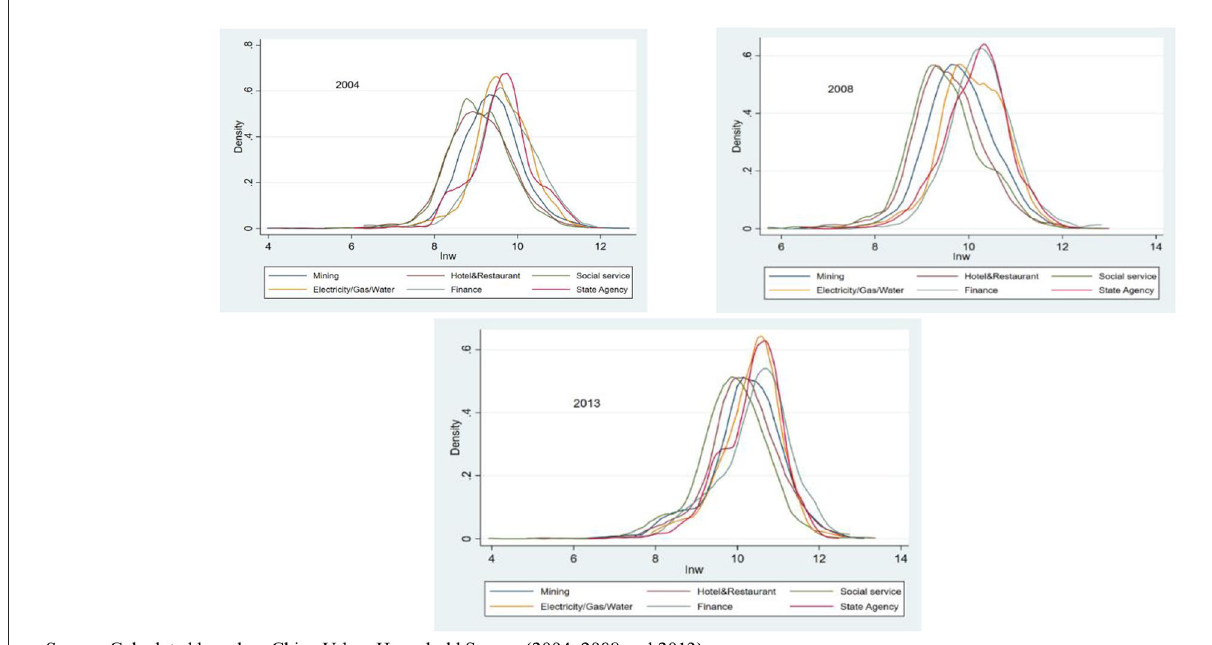
FIGURE5 Kernel density distribution of wages by representative industry for 2004, 2008, and